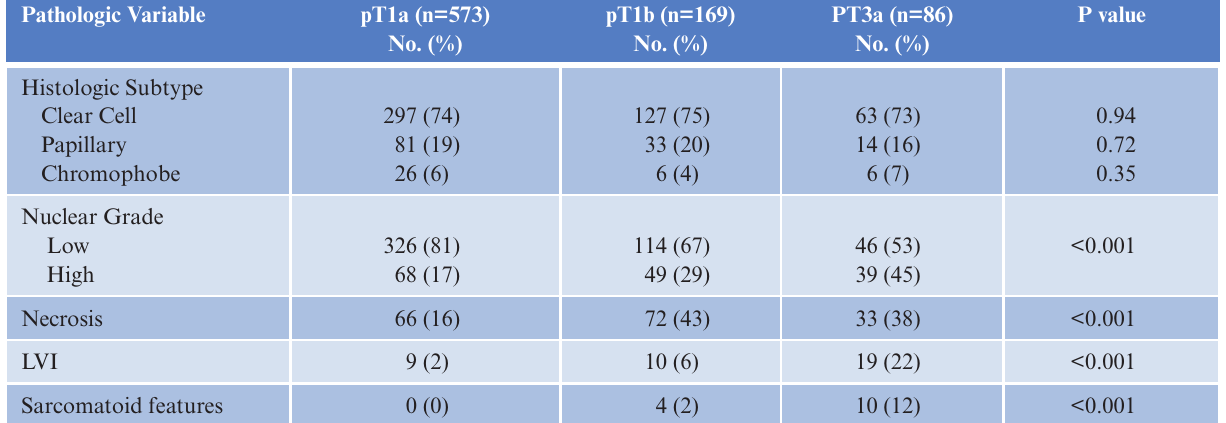
Table 4: Pathologic characteristics of 659 RCC tumors ≤ 7cm in size stratified by stage (pT1 vs. pT1b vs. pT3a) Pathologic